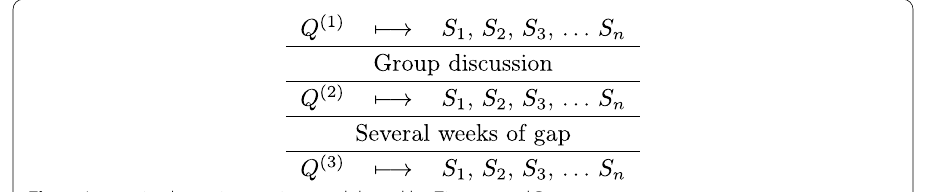
Fig. 4 Improvised peer instruction model used by Zingaro and